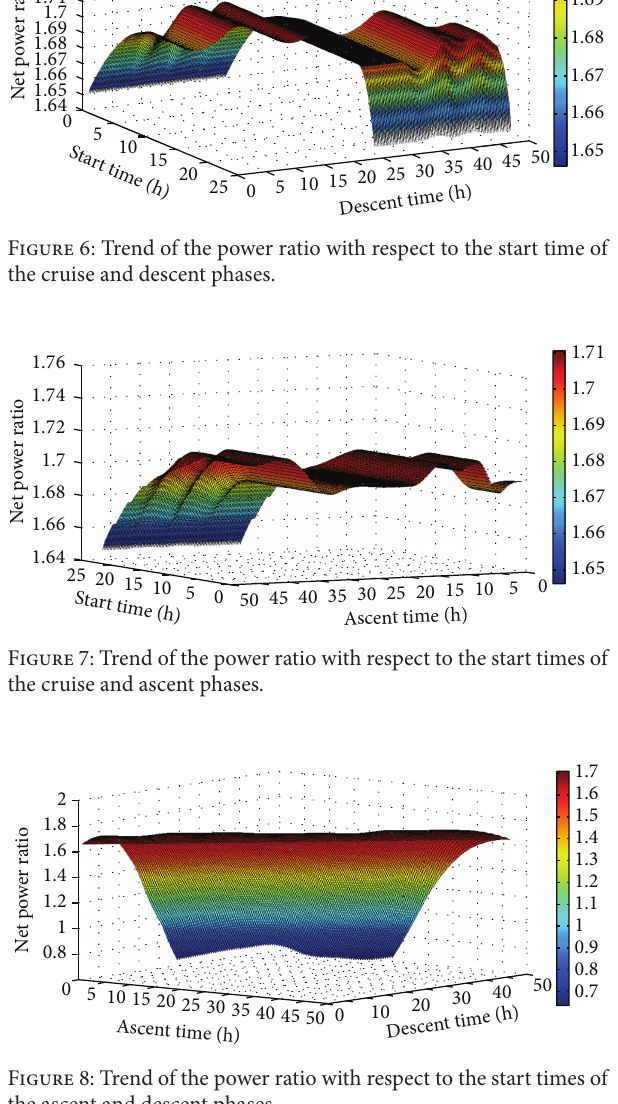
Figure 8: Trend of the power ratio with respect to the start times of the ascent and descent